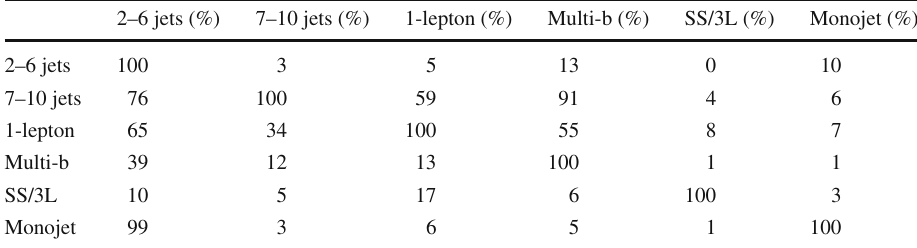
Table 4 Exclusion overlap: percentage of models excluded by a Run 2 analysis on each row that is also excluded by another in the columns. 100% is reserved for complete overlap of models excluded